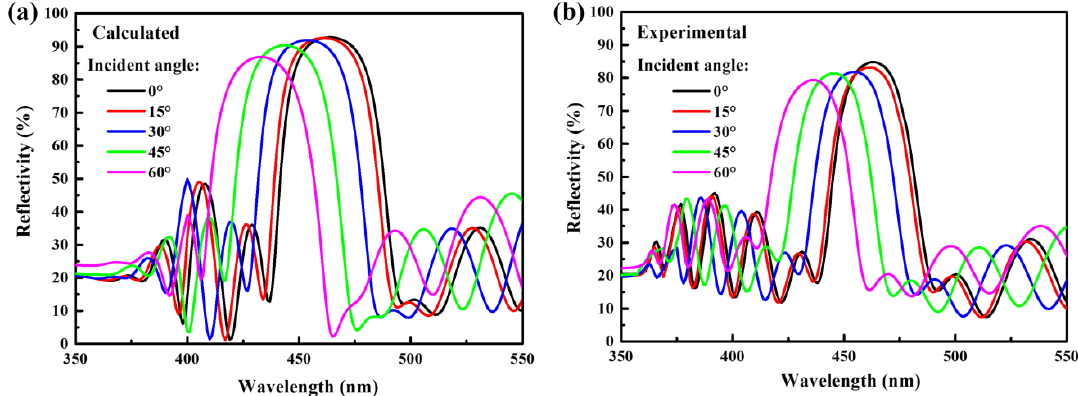
Figure 5. ( a ) The calculated and ( b ) experimental reflectivity of 9-pair AlN/GaN DBRs under different incident angles.